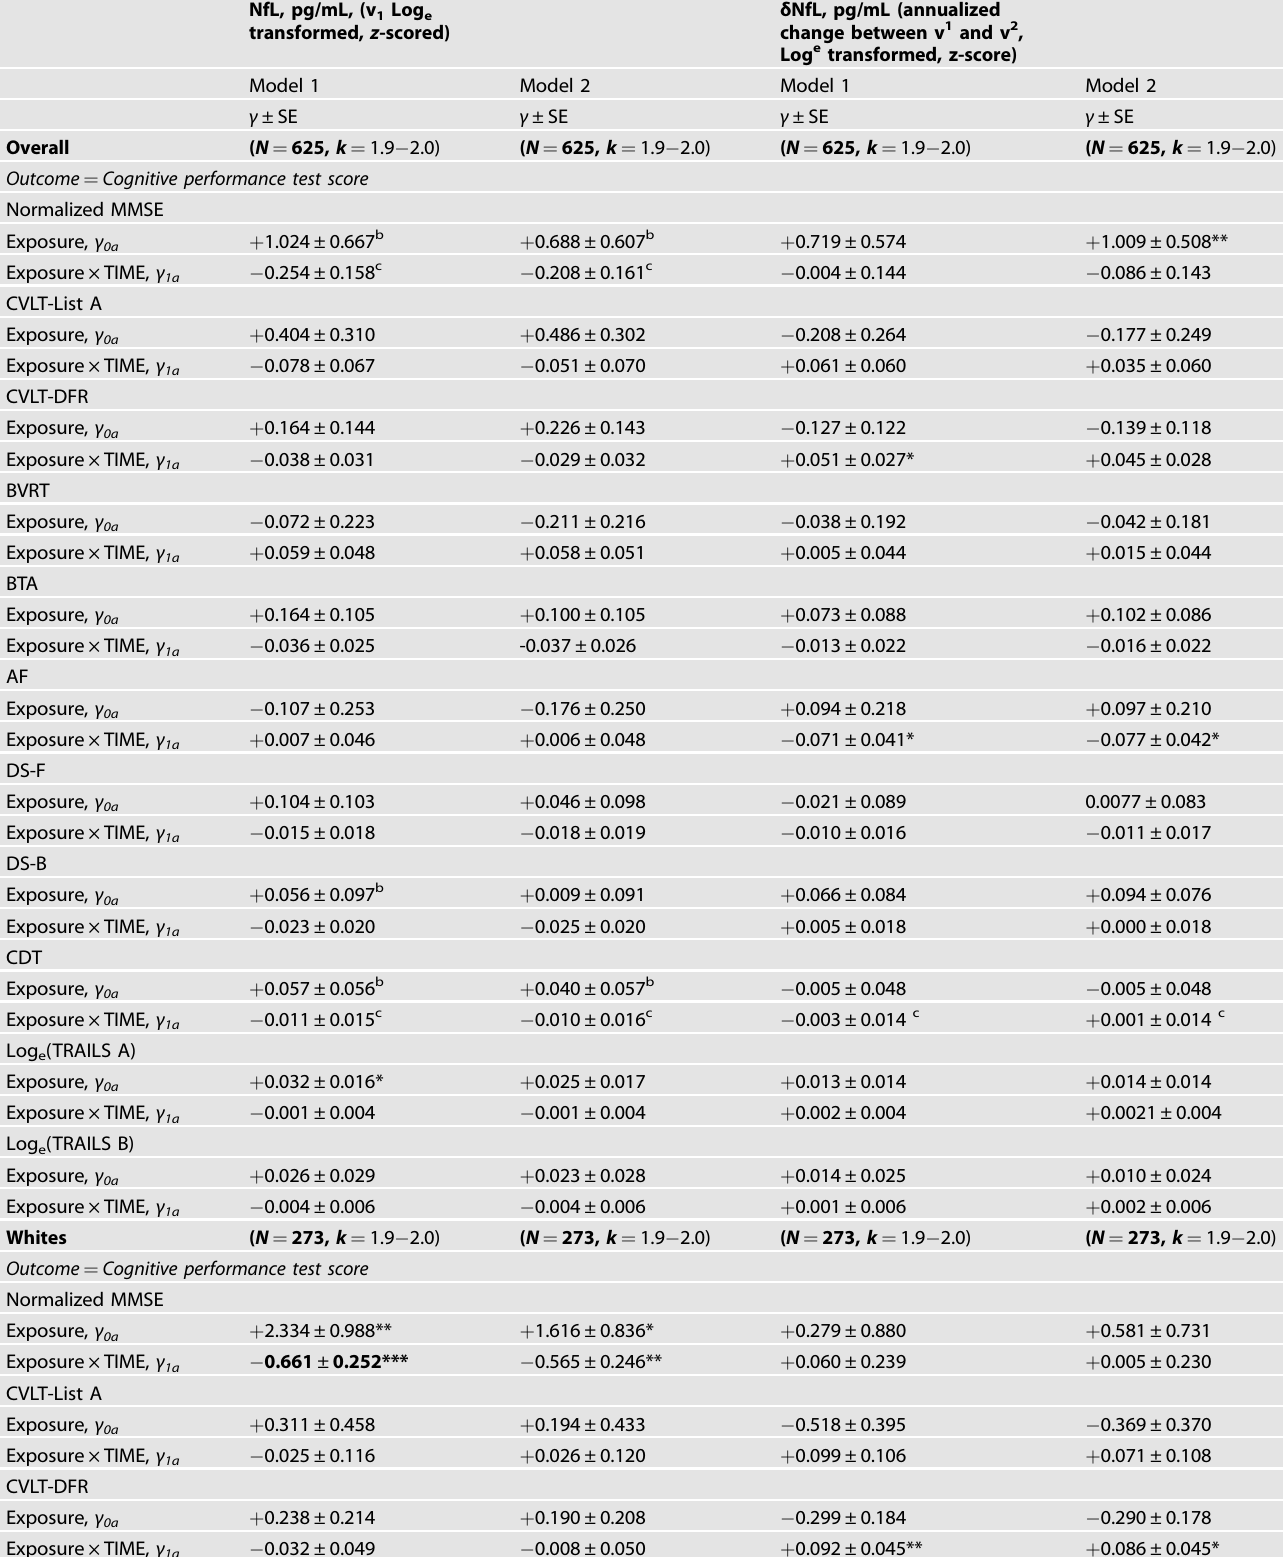
Table 2. Baseline and annual rates of change in plasma neuro fi lament light (v 1 NfL, and δ NfL) and their association with cognitive performance at v 1 and change over time: overall and race-speci fi c mixed-effects linear regression models: HANDLS 2004 – 2013 a